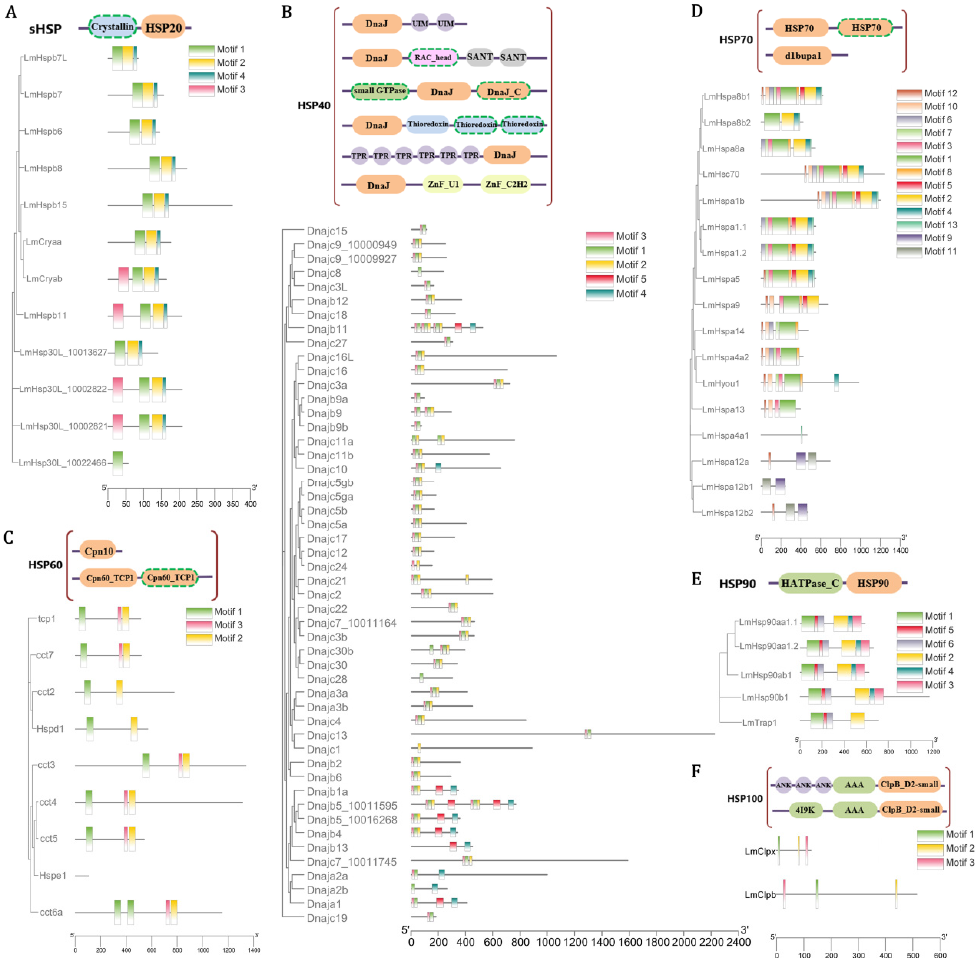
Figure 2. Conserved domain architecture of LmHsp families, as ( A ) LmsHsp s, ( B ) LmHsp40 s, ( C ) LmHsp10/60 s, ( D ) LmHsp70 s, ( E ) LmHsp90 s, and ( F ) LmHsp100 s, showing along their phylogenetic relationships. The horizontal grey bars represent amino acid sequences without predicted functional domains, whereas the colored boxes represent the regions with successfully predicted motifs. The orange boxes represent the corresponding HSP domain of each family, the green boxes represent the ATPase domains, and the other boxes represent specifically annotated domains. The domains that appear only in some family members are marked with dashed frames.